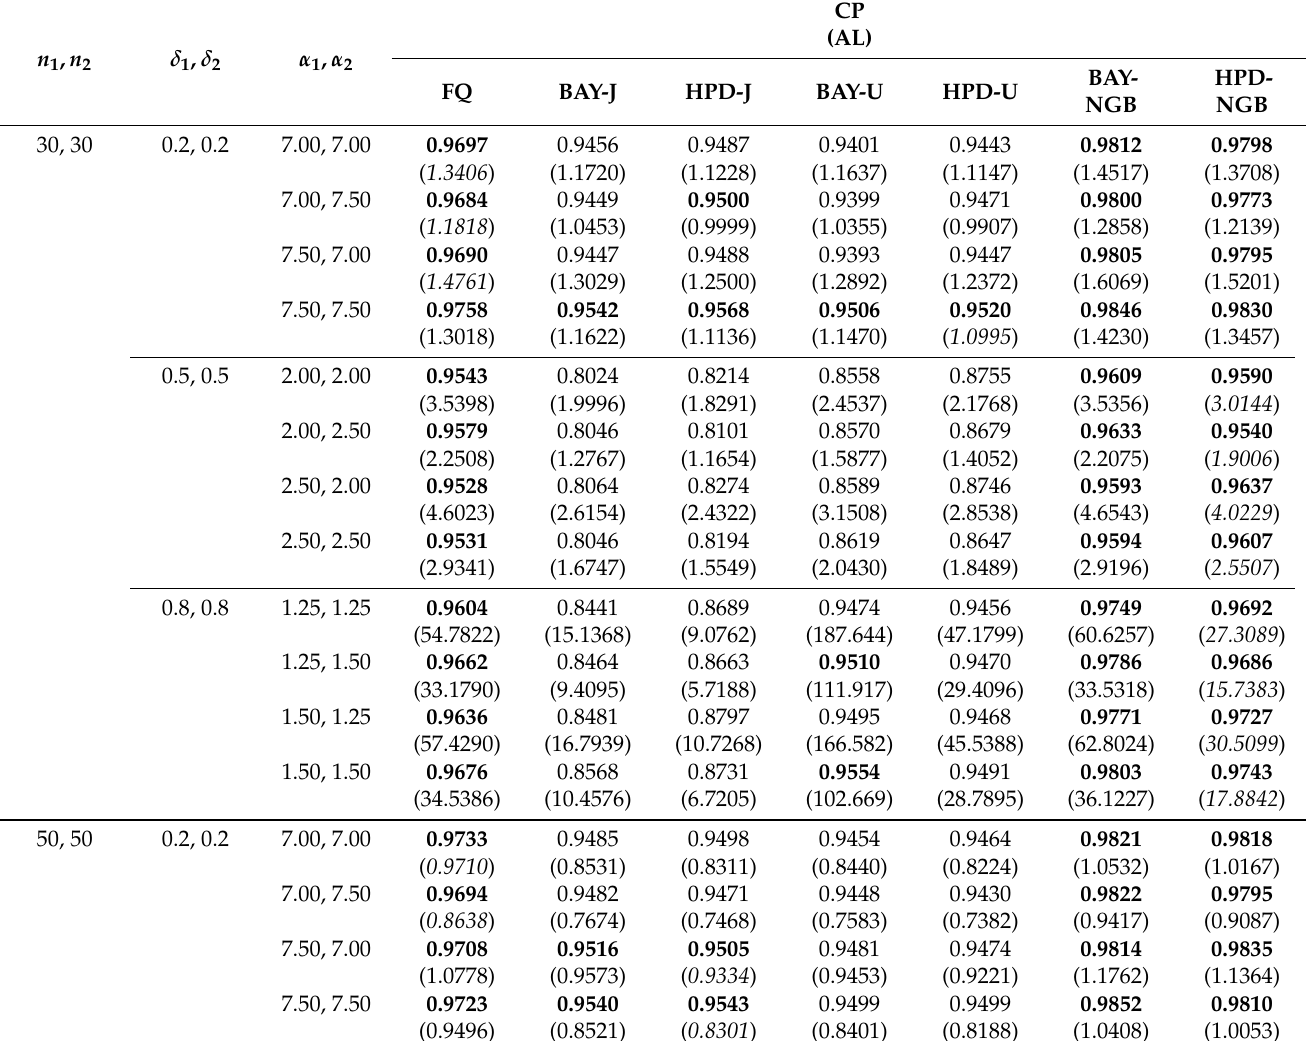
Table 1. The CPs and (ALs) of nominal 95% two-sided confidence interval for the ratio of variances of delta-gamma distributions ( n 1 = n 2 )